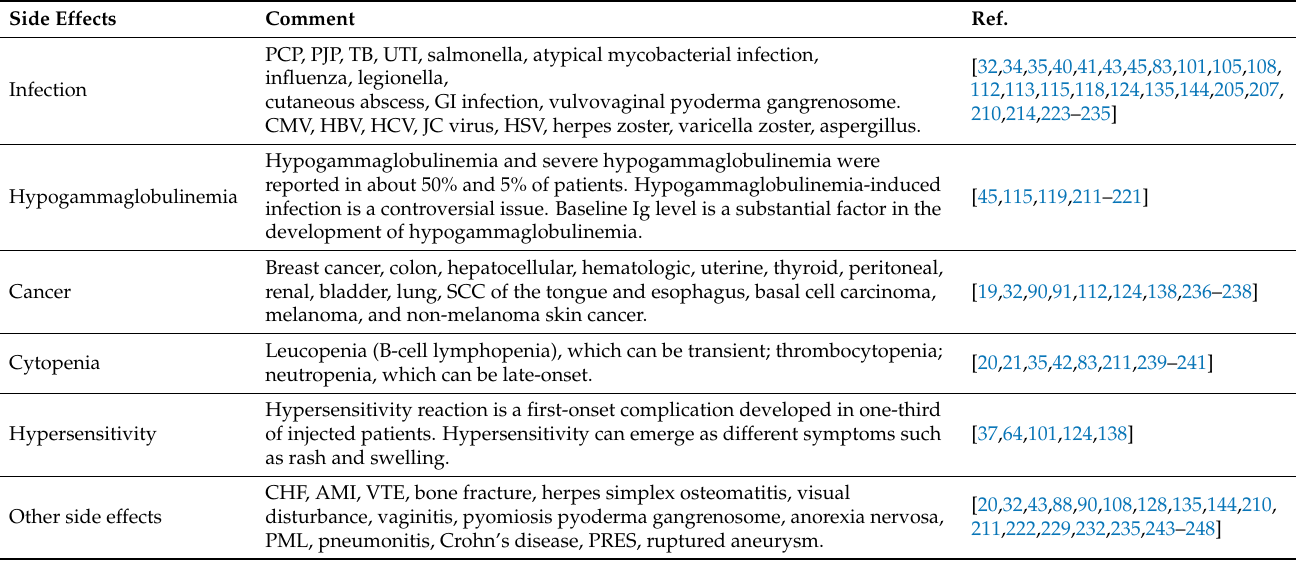
Table 3. Safety profile of RTX therapy in AAV